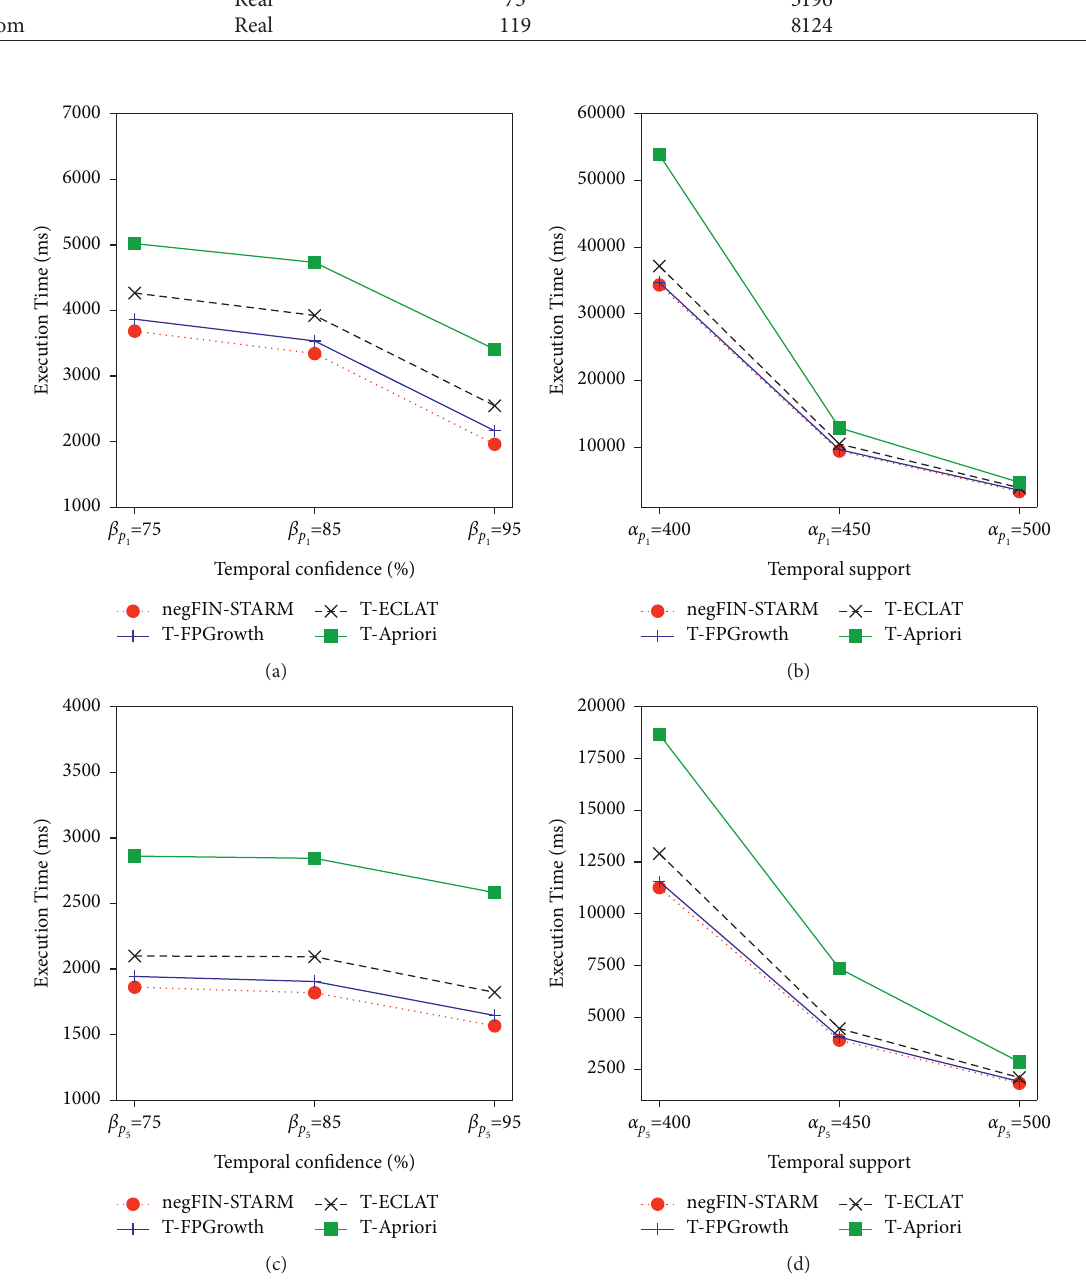
Figure 2: The runtime comparison of four methods based on the chess data set. (a) Q � p � 500. (d) Q � p Q � p 􏼈 􏼉 and α p 5 5